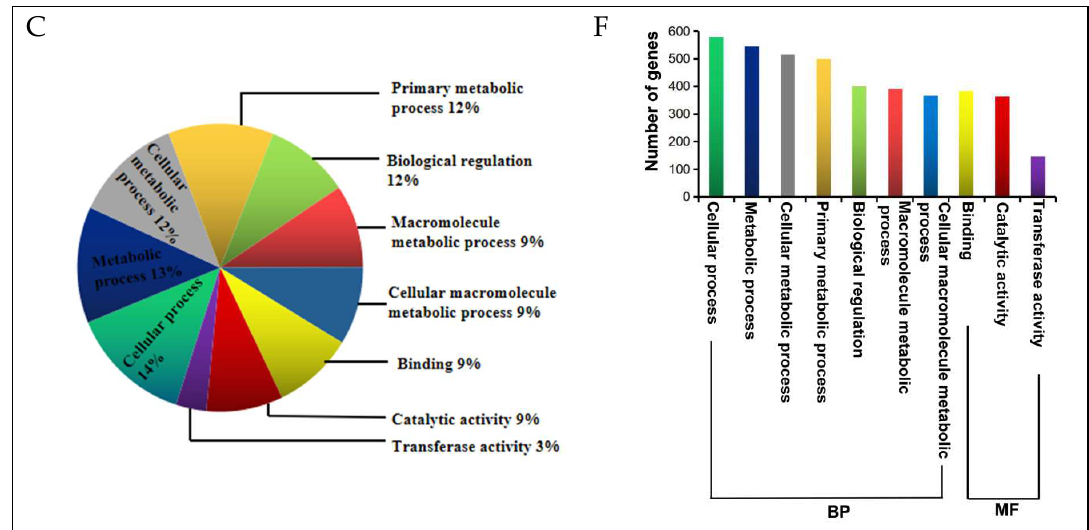
Figure 4. Gene ontology (GO) enrichment analysis of the DEGs (from the critical areas labelled I, II, and V in Figure 2) in specific level 2 GO terms. The GO analysis results shown here are for the top 10 GO terms from the biological processes (BP) and molecular functions (MF) categories combined, for ( A ) GO enrichment of DEGs corresponding to tolerant treatment response (TC_TD); ( B ) GO enrichment of DEGs corresponding to line response under drought (SD_TD); and ( C ) GO enrichment of DEGs corresponding to sensitive treatment response (SC_SD); ( D – F ) Number of DEGs enriched in each specific GO term in each experimental comparison (TC_TD, SD_TD, and SC_SD, respectively). Each area contained a background total of 80, 5140, and 602 DEGs, for TC_TD, SD_TD, and SC_SD, respectively.